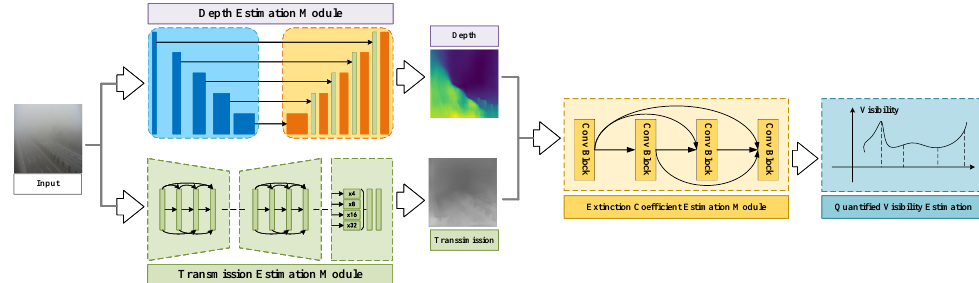
Figure 2. Overall architecture of the proposed